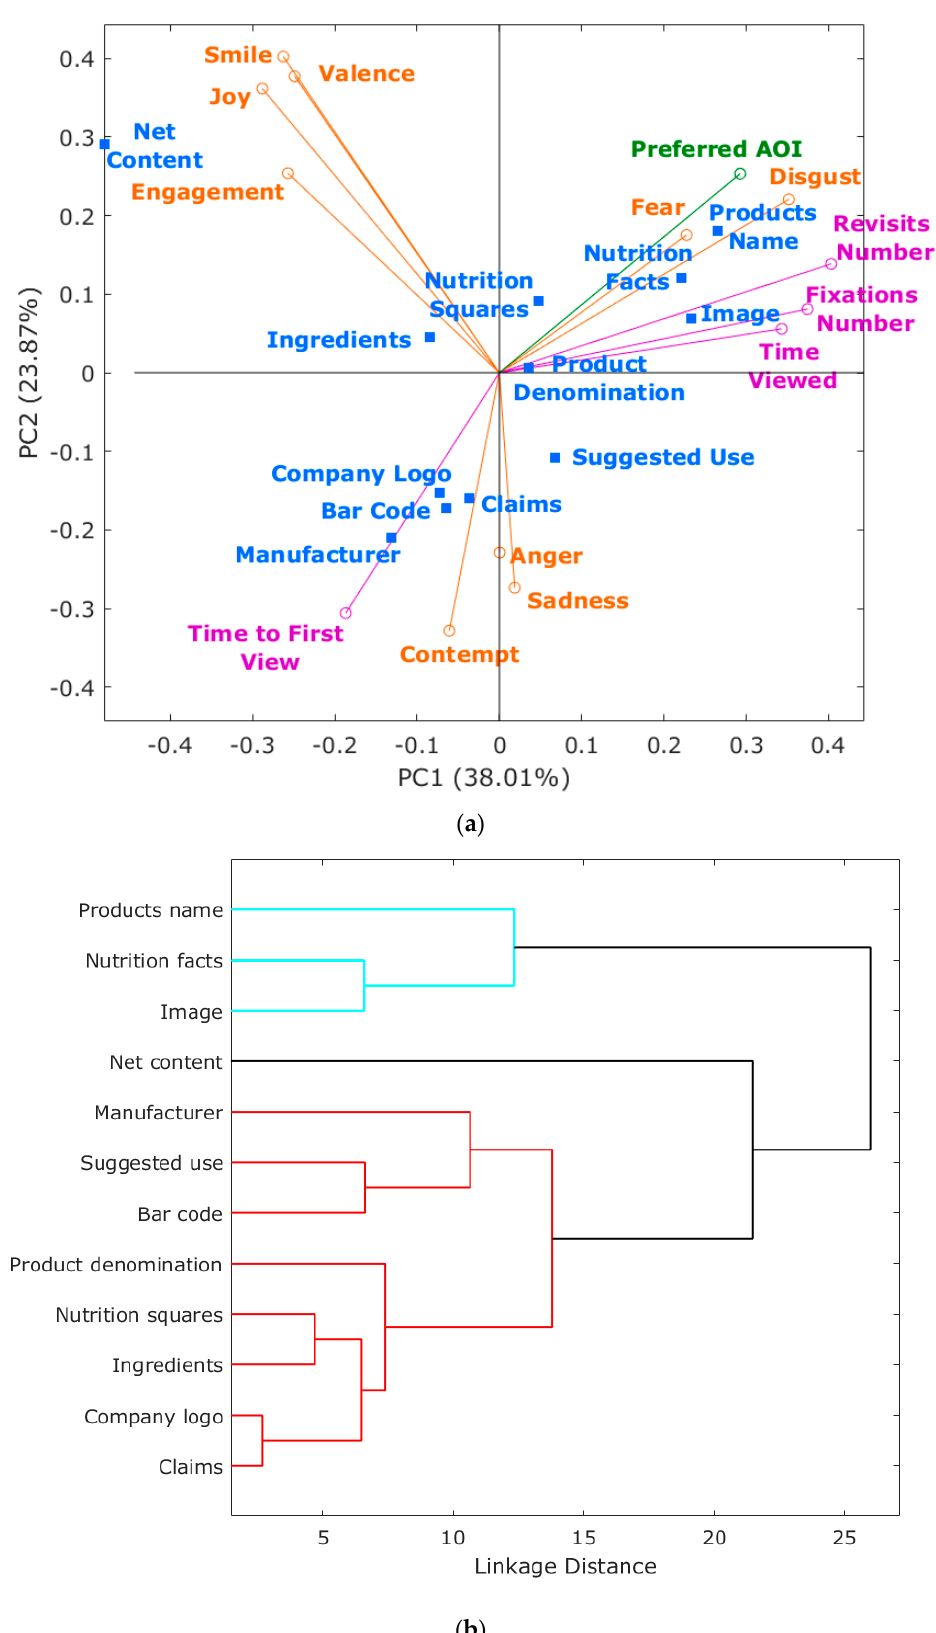
Figure 6. Multivariate data analysis based on ( a ) principal components analysis (PCA) and ( b ) cluster analysis. Abbrevia- tions: PC: Principal Component; AOI: Area of Interest.